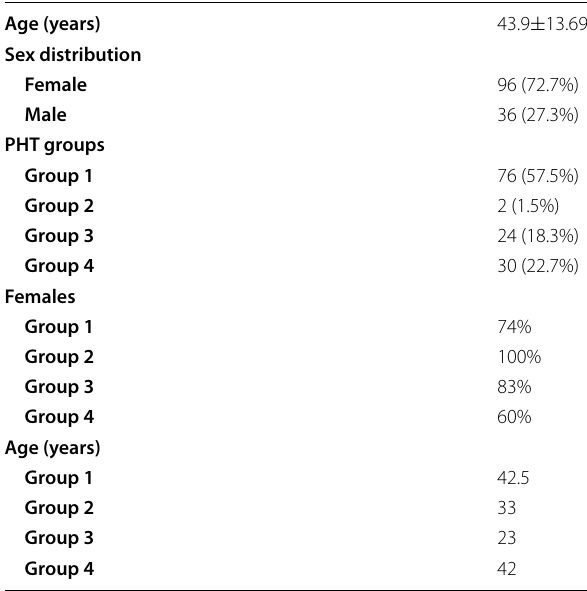
Table 1 Patients’ characteristics ( n